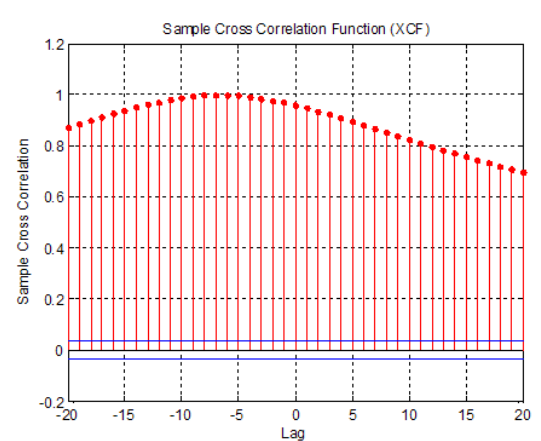
Figure 5. Two data are similar.